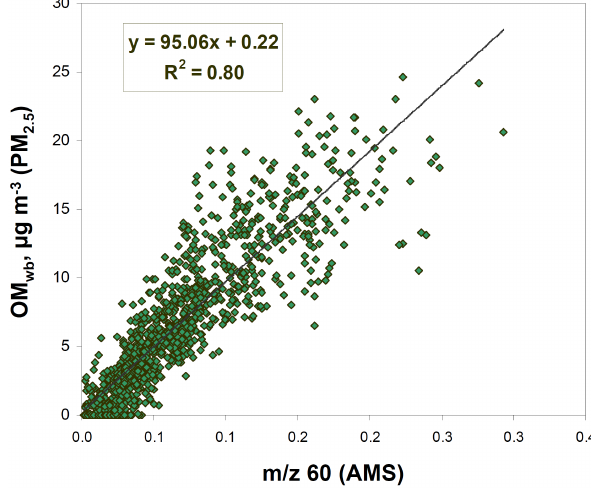
Figure 9 Fig. 9. Scatterplot of OM wb , as calculated by the Aethalometer model, versus the m/z 60 mass fraction measured by the AMS (15- min averaged